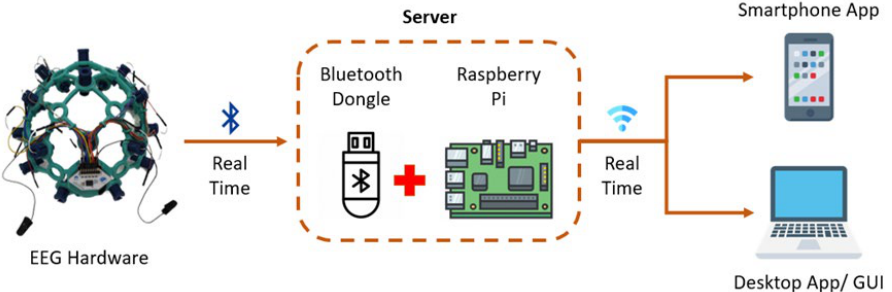
Figure 4. EEG device architecture.